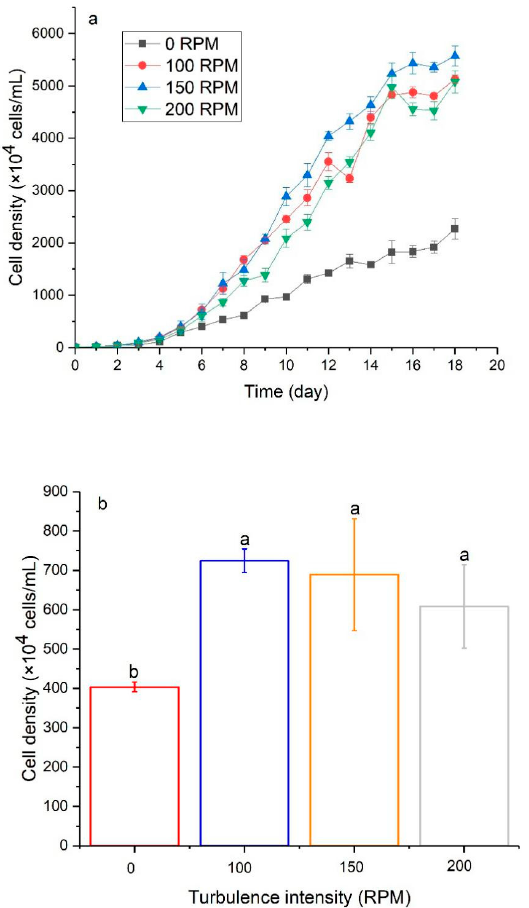
Figure 2. Cell density ( a ) and the 6th-day density ranges ( b ) under different turbulent intensities. Error bars represent the standard deviation (SD) of triplicate samples. Some error bars are too small to show. Different letters indicate significance between different treatments ( p < 0.05).